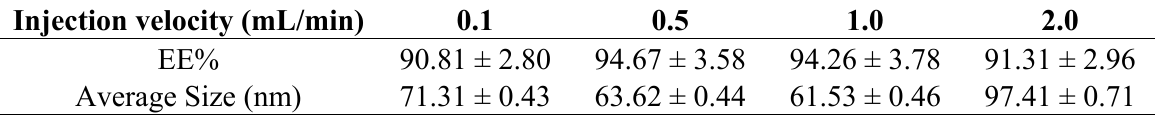
Table 2. Study of injection velocity of organic phase (